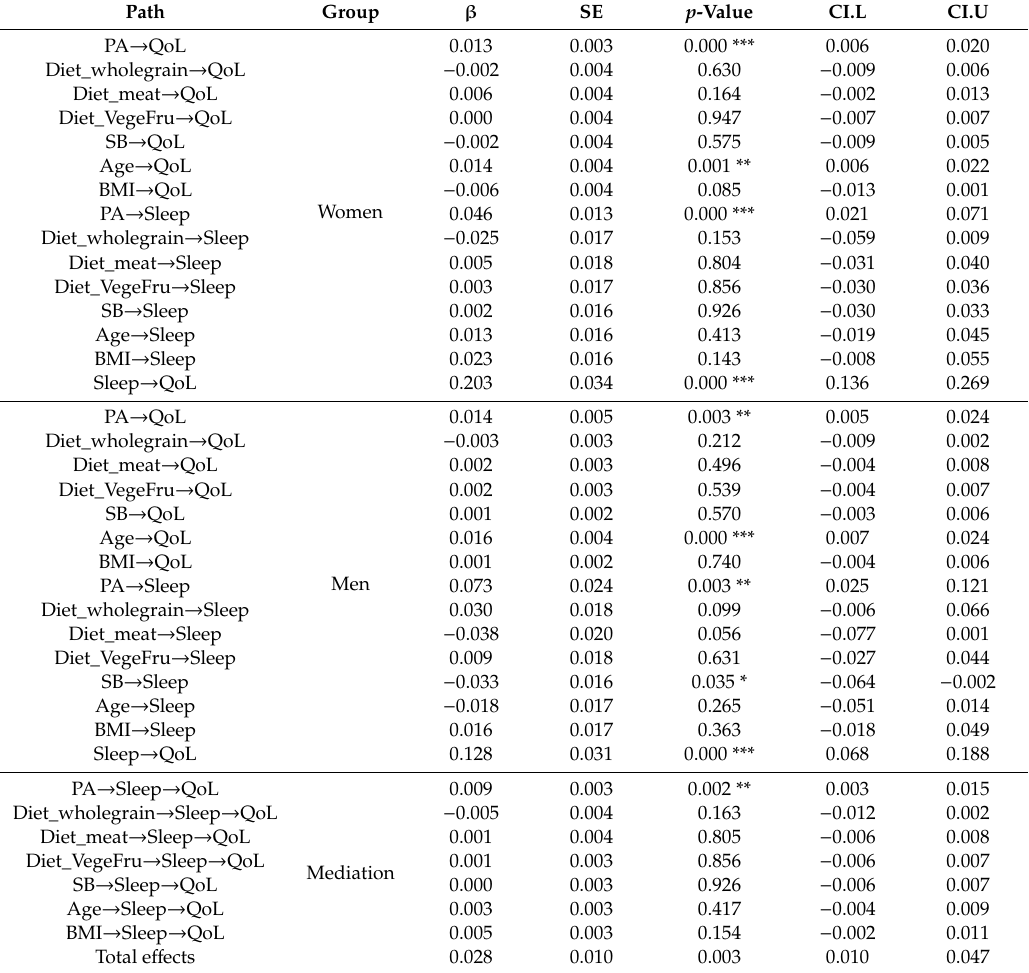
Table 4. Direct and indirect associations between physical activity levels, sedentary behavior (SB), diet, sleep quality, and the quality of life